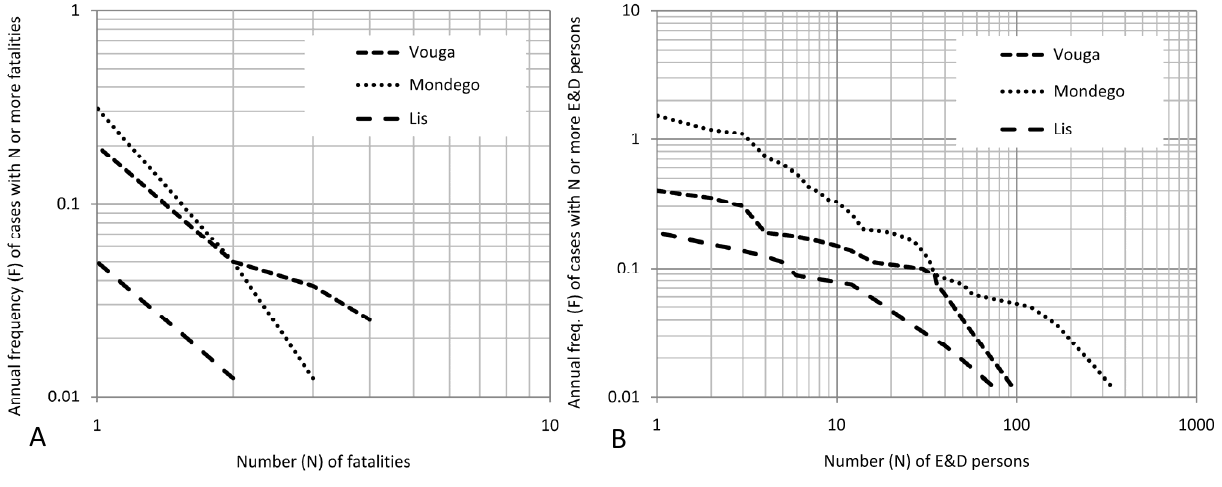
Figure 5. F-N curves for the number of fatalities (D & D) ( A ); and evacuated and displaced persons ( B